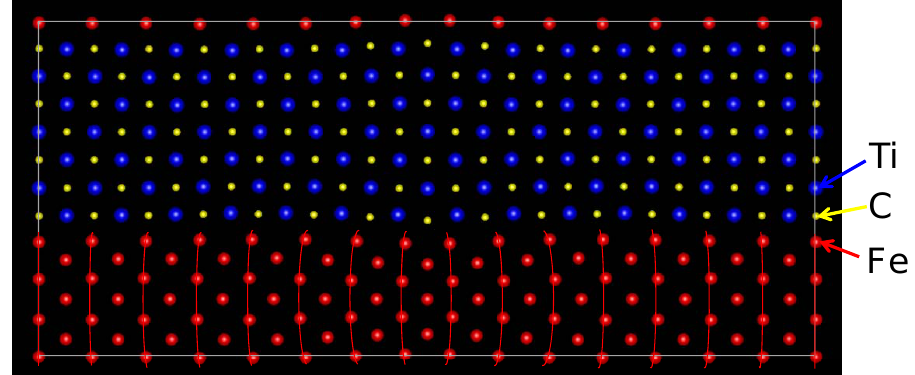
Figure 4. Optimized arrangement of atoms in the semi-coherent interface with m : n = 15:14 in the (110) plane. The Fe atoms are connected along the [001] direction using red lines for